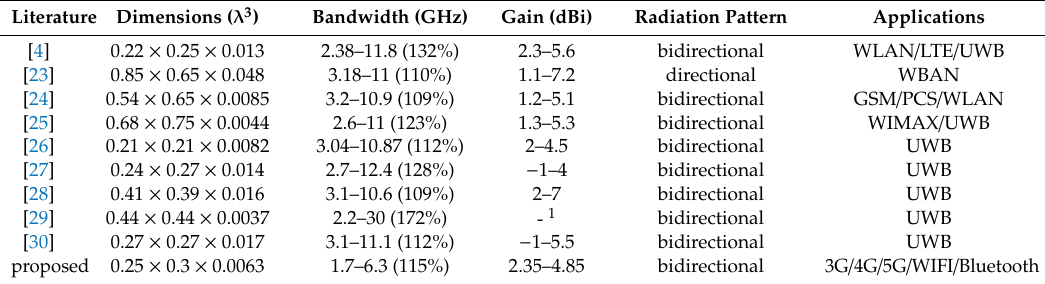
Table 3. Comparison of the proposed antenna with the antennas available in